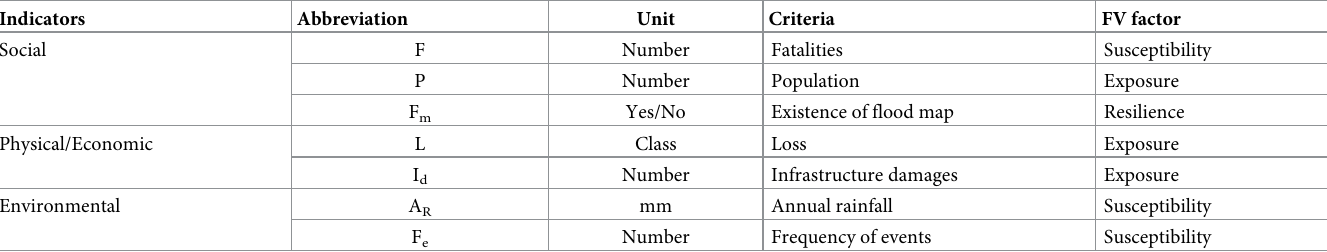
Table 2. FV indicators adopted for the